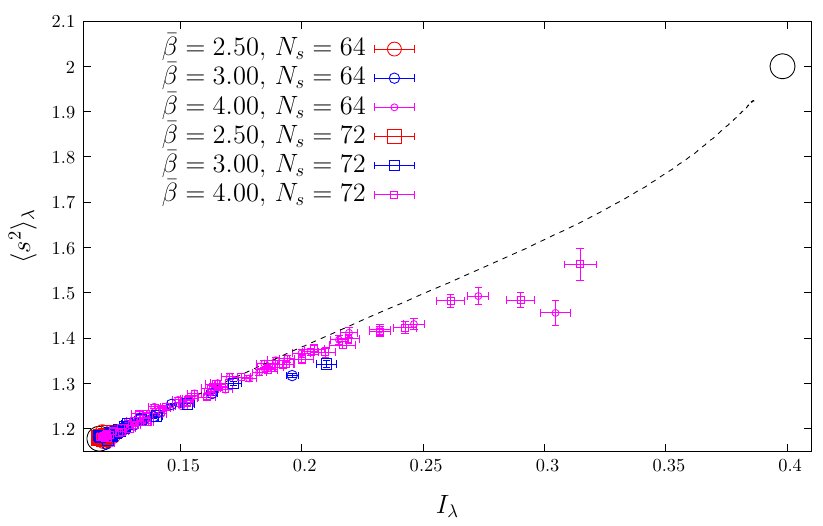
Figure 16 . Shape analysis in the low-temperature phase. Only points with